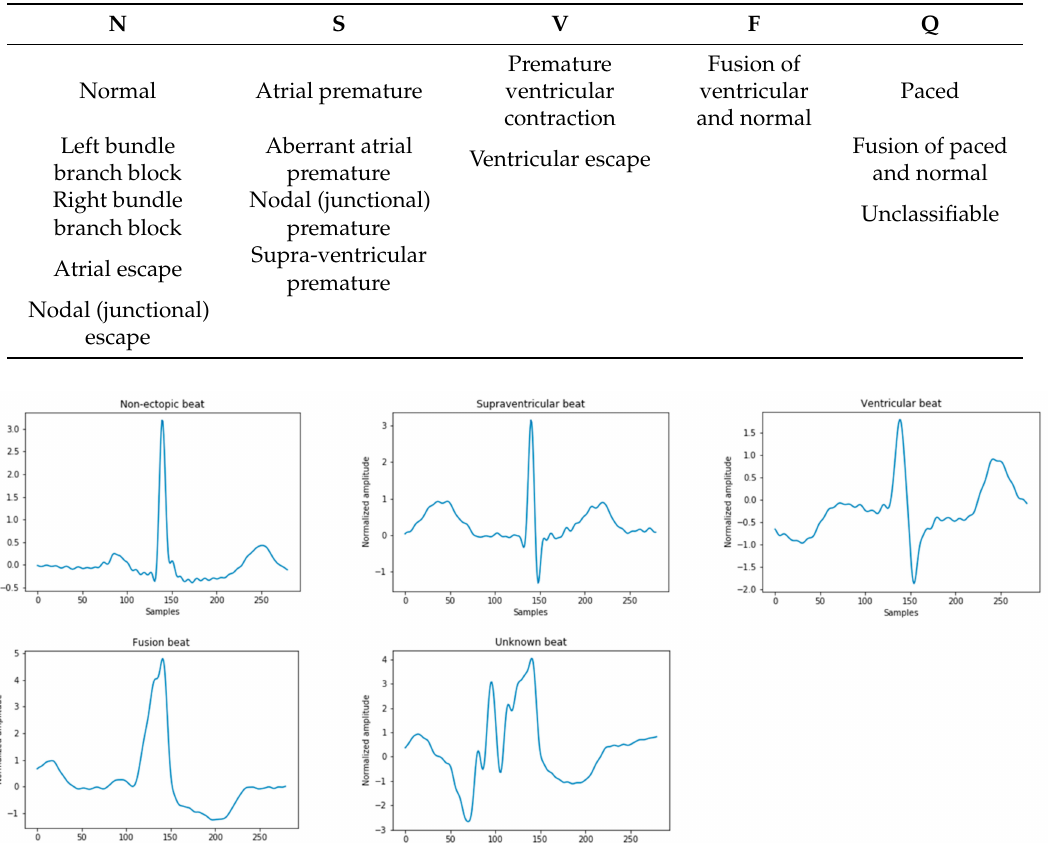
Figure 2. Five types of heartbeat instance diagrams that meet the Association for the Advancement of Medical Instrumentation (AAMI)